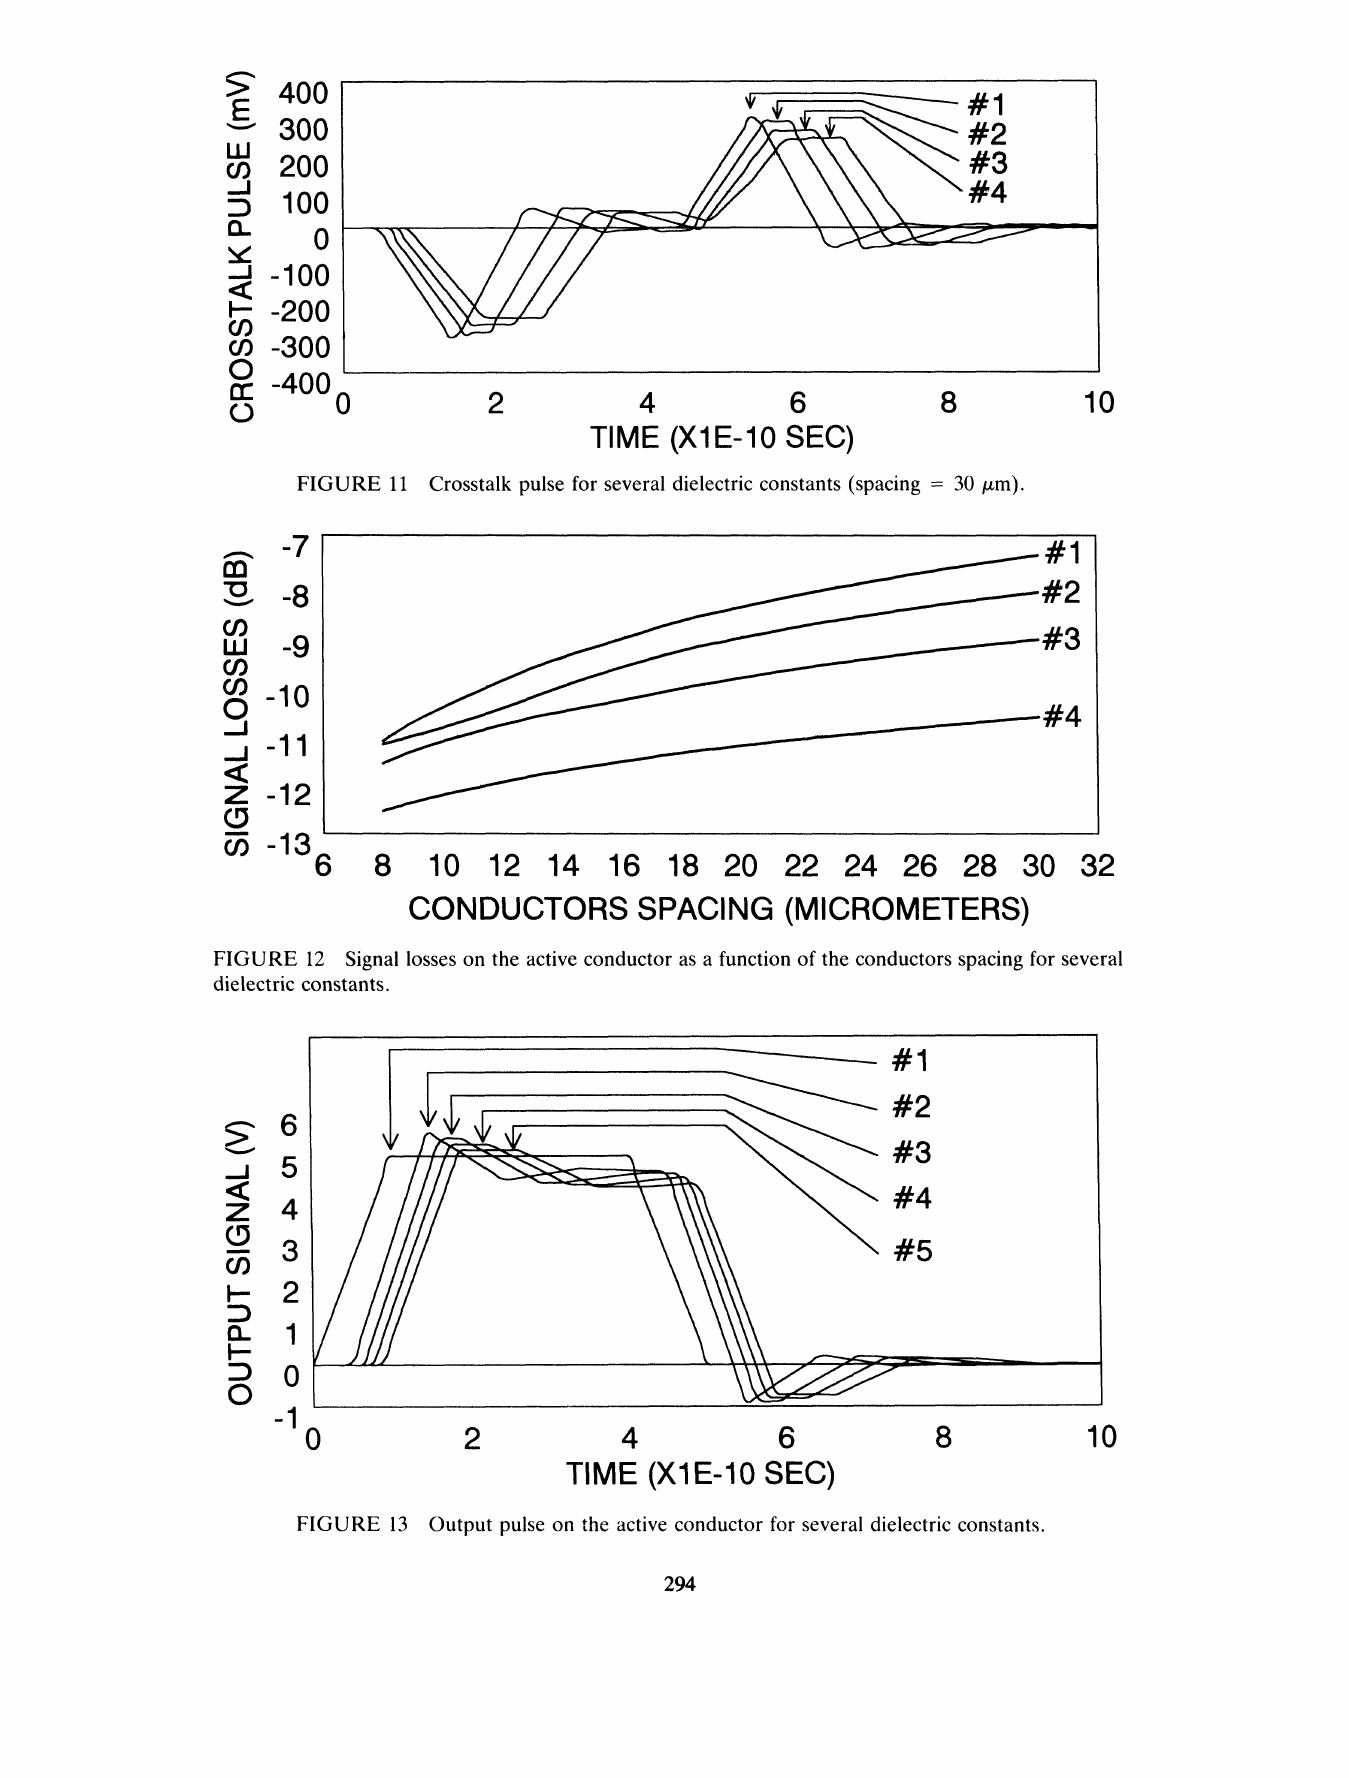
FIGURE 13 Output pulse on the active conductor for several dielectric constants.